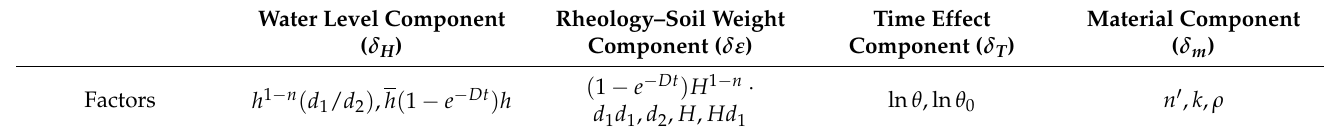
Table 1. Input variable